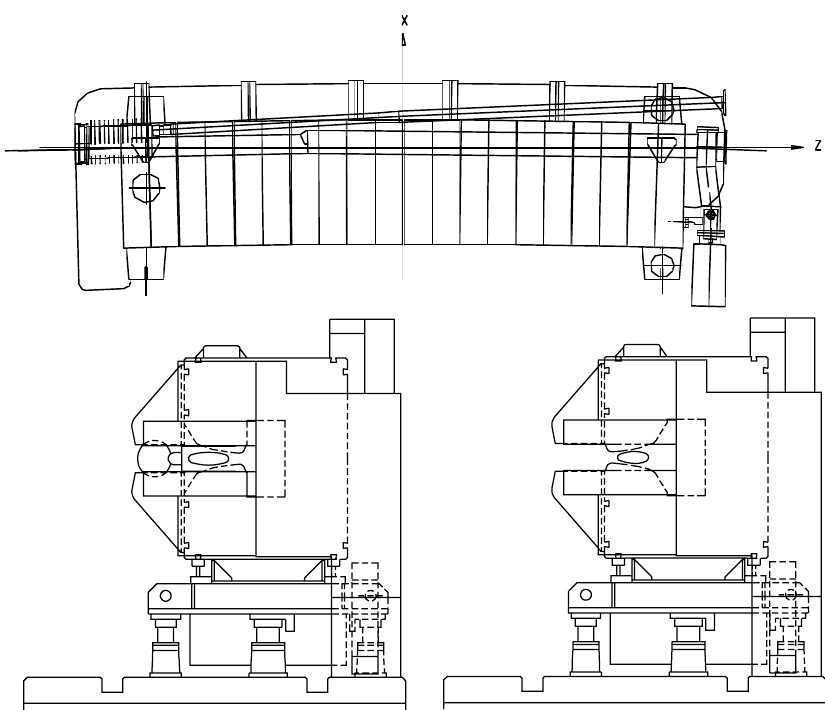
FIG. 1. PS magnet unit 16. This unit is located just downstream of the extraction septum. The overall layout is shown in the upper part. The vacuum pipes for the circulating beam as well as that for the extracted one are visible. The two cross sections of the entry face (with open gap) and exit face (with closed gap) of the magnet are also shown on the left and right,